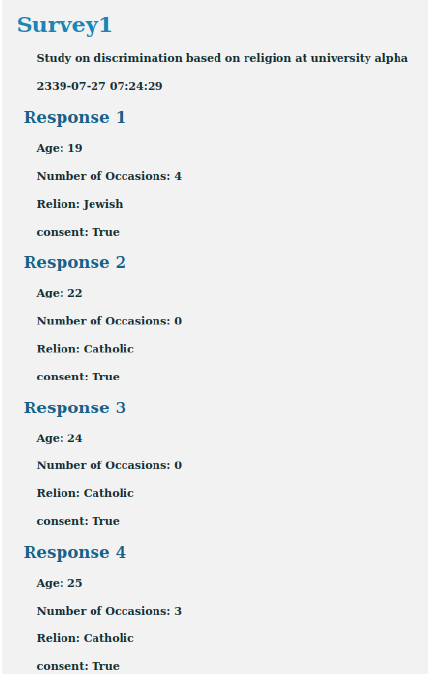
Figure 5. Survey’s